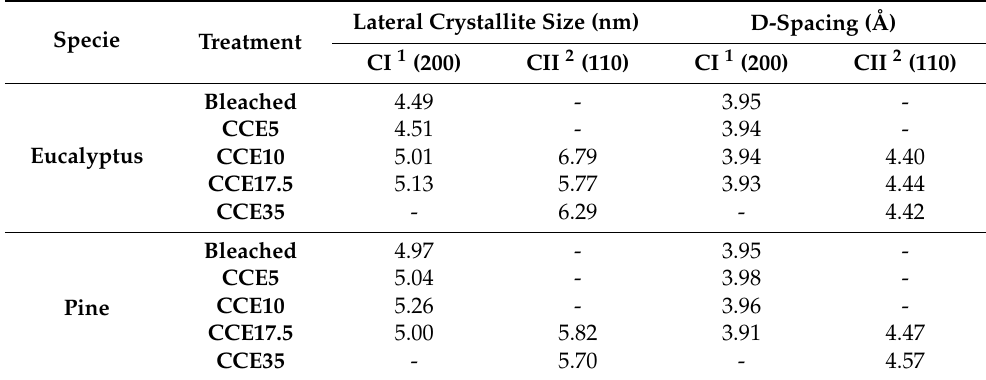
Table 4. Lateral crystallite size and d-spacing of hydrophobic planes of cellulose I (200) and cellulose II (110) in eucalyptus and pine samples. Standard deviation lower than